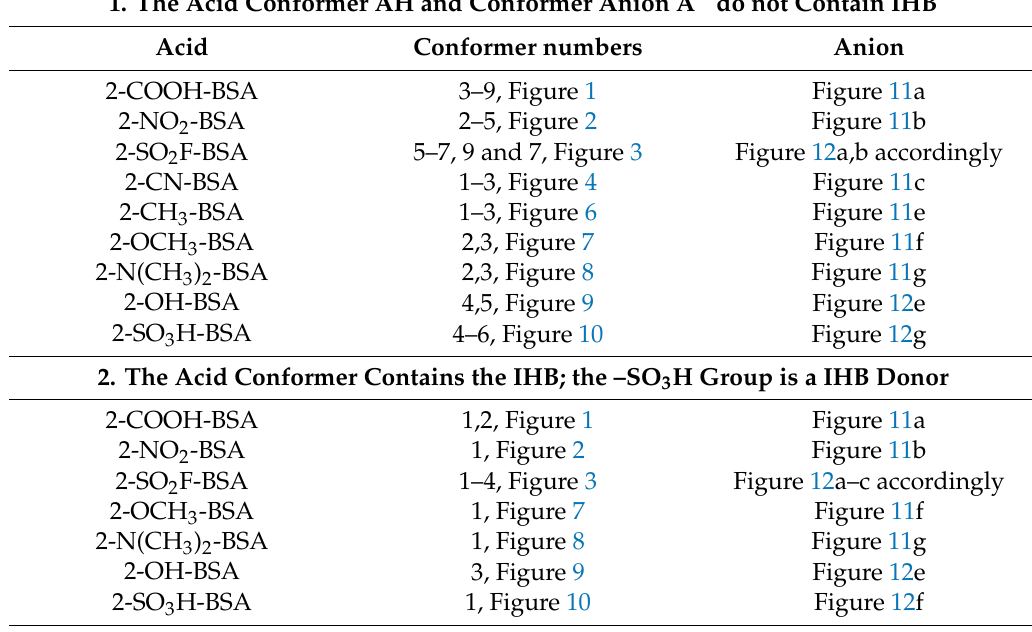
Table 3. Conformers of acids AH and anions A − , which are formed under their